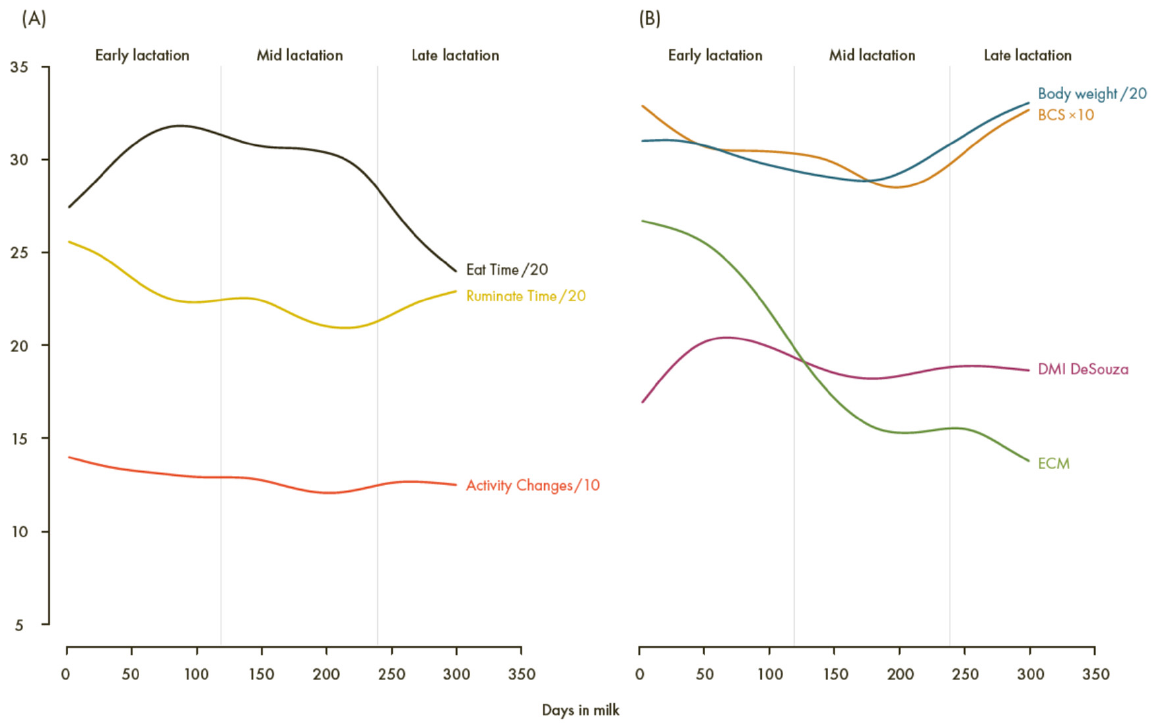
Figure 2. Influence of days in milk (DIM) on ( A ) the chewing behavior parameters rumination time (min/d), eating time (min/d) and number of activity changes (n/d), and on ( B ) the efficiency-related parameters body weight, body condition score (BCS), dry matter intake (DMI) based on the formula of de Souza et al. (2019) and daily energy-corrected milk yield (ECM). Lines represent the smooth splines between DIM and the corresponding variable. Variables have been multiplied or divided by the values added to the labels. Vertical lines represent 120-day intervals of DIM.